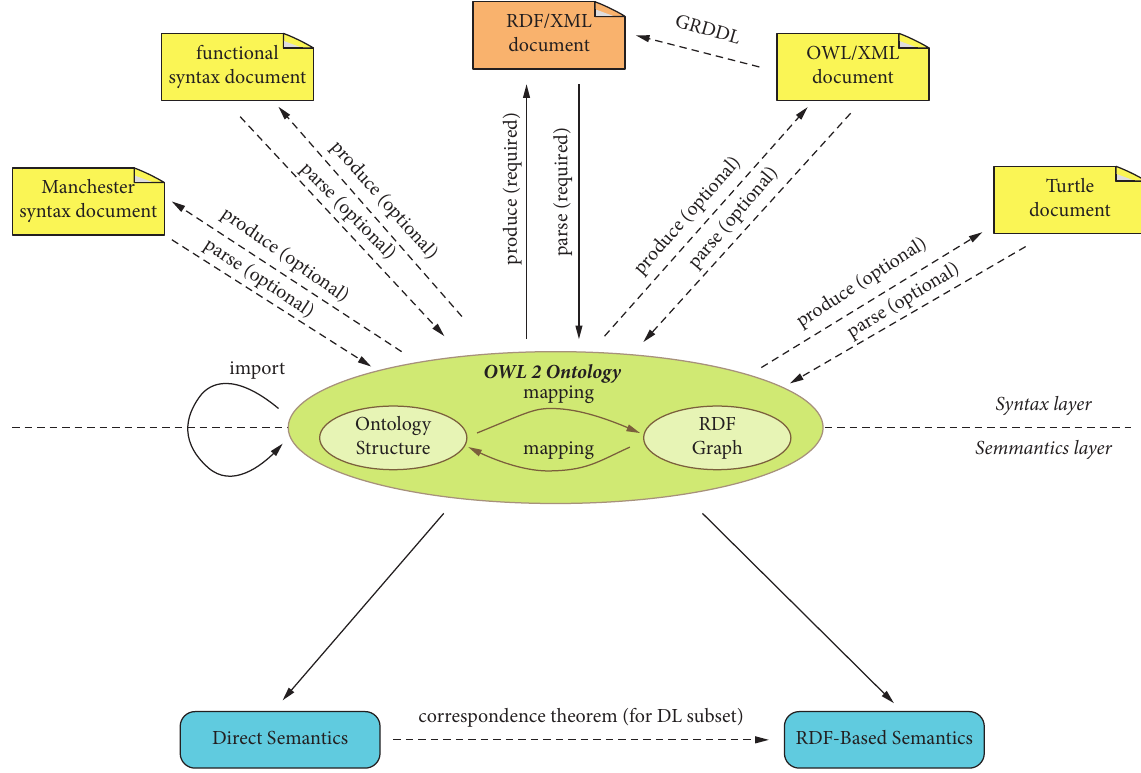
Figure 8: The structure of OWL 2 (Web Ontology Language)